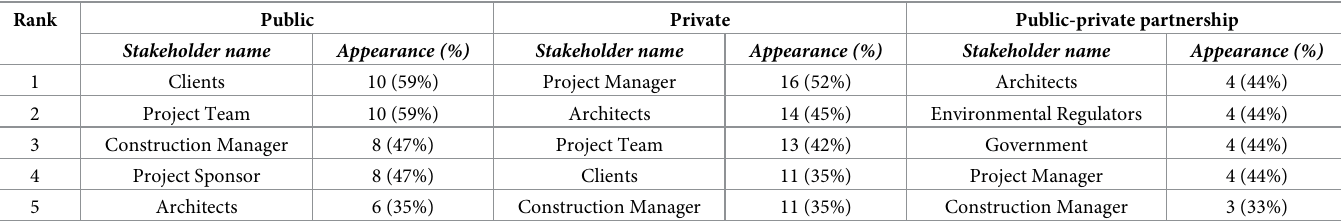
Table 2. Top-5 nodes that appeared most in the three different types of stakeholder networks. The proportion of percentage appearance in parentheses follows the count value. All values in this table are significant at p < 0.001, resulting from a t-test.